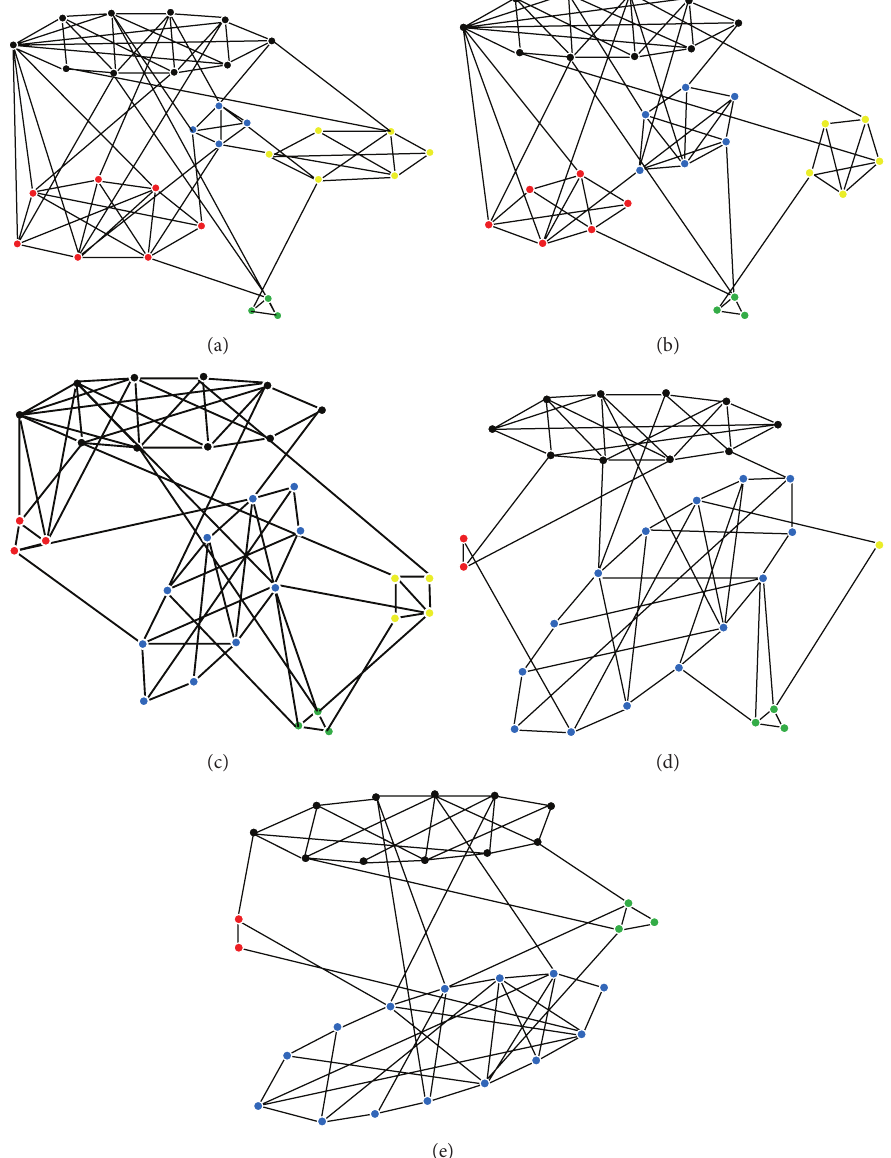
Figure 1: It is a visualization of change of networks’ structure in a predicted sequence from 𝑖Δ𝑡 to (𝑖+4)Δ𝑡 , which shows a simple integration process. Different partitions are distinguished by different colors of